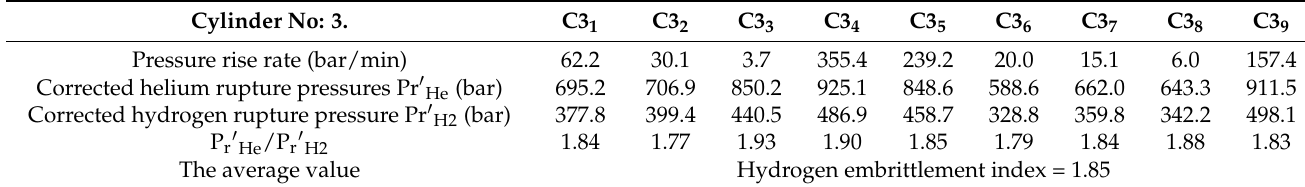
Table 6. The P r (cid:48) He /P r (cid:48) H2 ratio of the shoulder of the three cylinders.